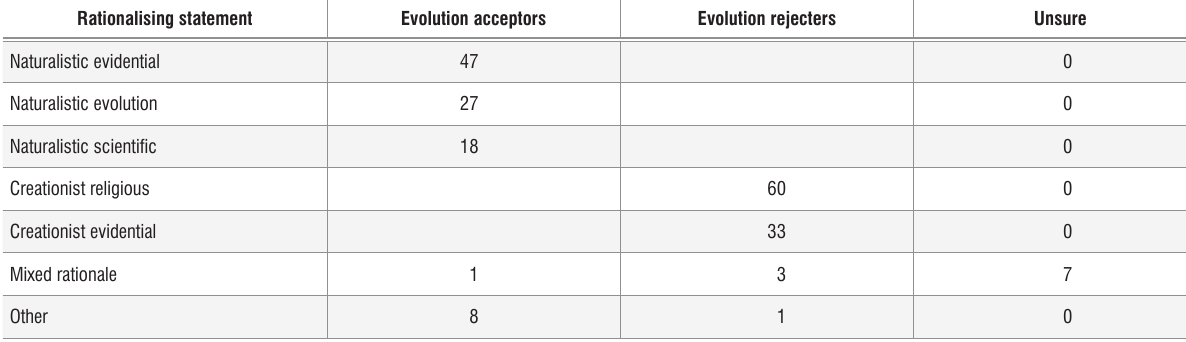
Table 5: Percentage of responses based on the conceptual framework using rationalising statements Rationalising